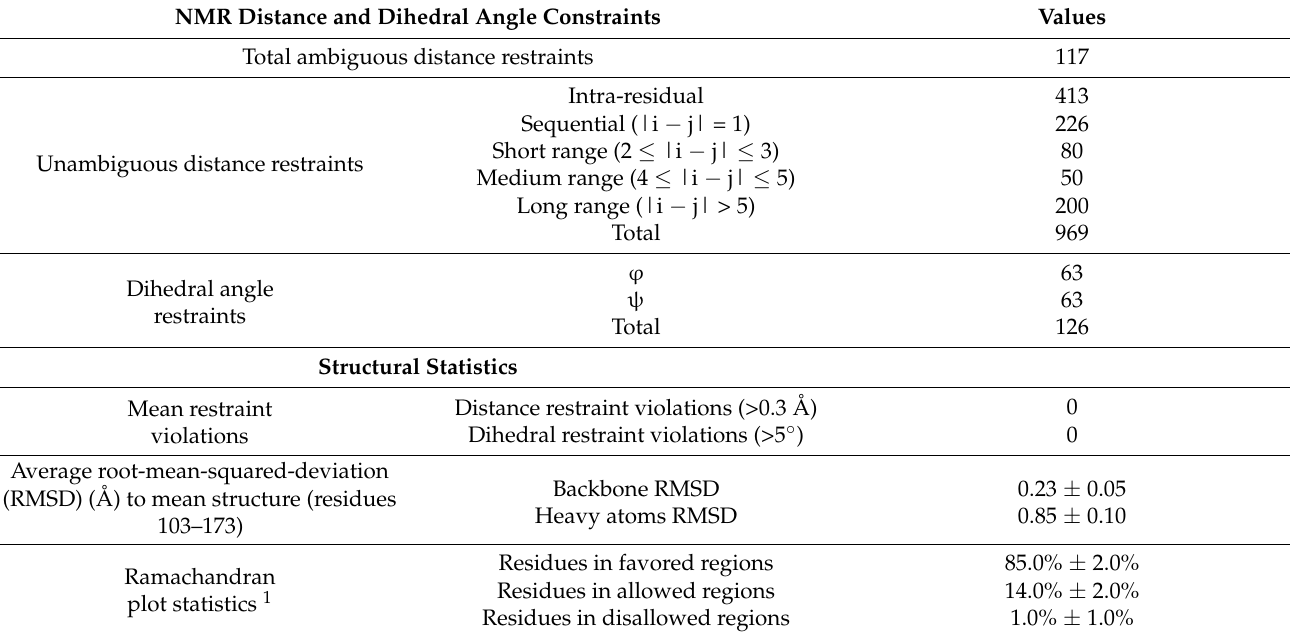
Table 1. NMR restraints and structural statistics for Mtb RimM CTD